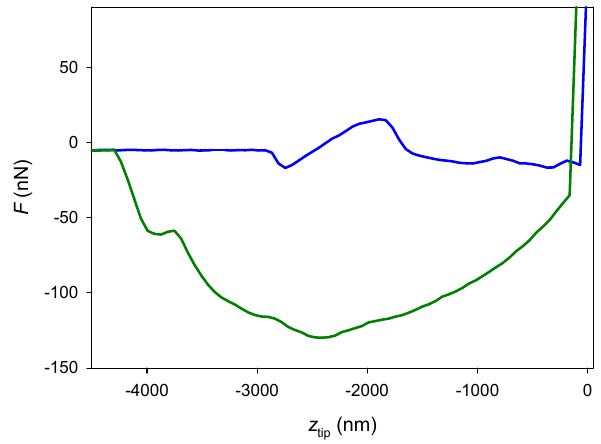
Figure 9. AFM force curve (approach, blue; and retract, green) per- formed with a platinum-covered tip over a thin glycerol film de- posited over silicon at a temperature of 5 ◦ C, using the